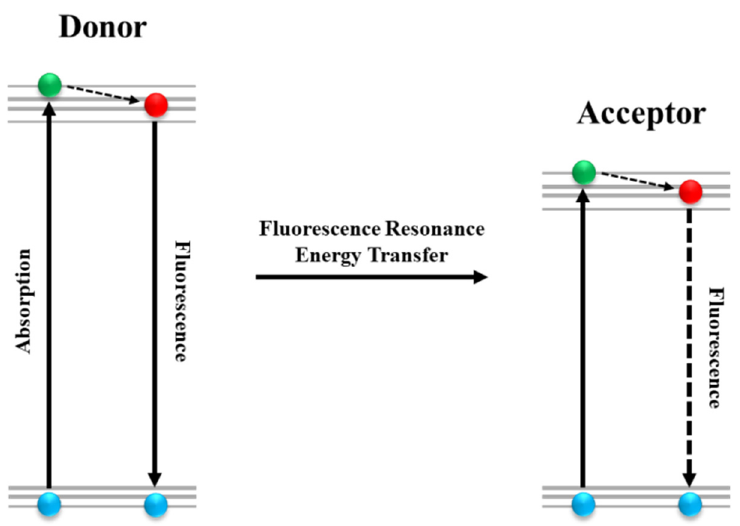
Figure 2. Schematic representation of the FRET process in the donor and acceptor containing sys-